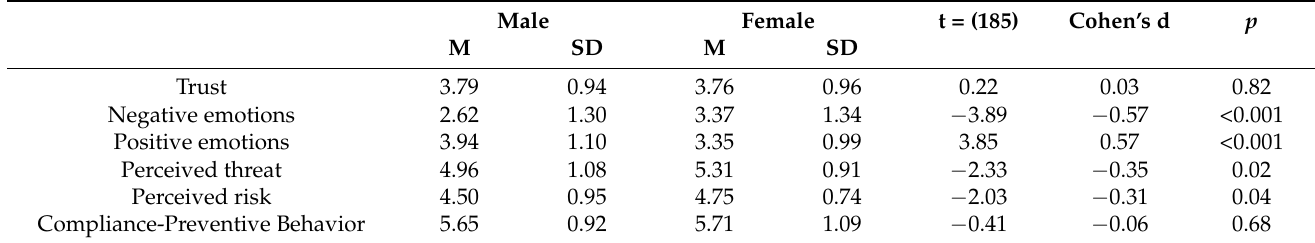
Table 3. Means, standard deviations, and t values for the study variables by